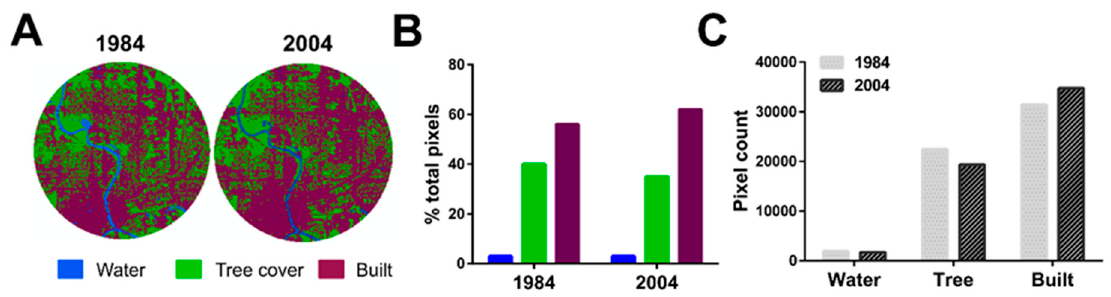
Figure 6. Changes in land use and land-cover near the Des Moines site from 1984–2004. A supervised classification of land use/land cover was performed for 1984 and 2004 to measure built-up land (maroon) and tree-covered land (green) over time using a 4km fixed area around the Des Moines trap site ( A ). Changes in land use/land cover classification are displayed by each year according to classification ( B ) or by classification over time ( C ). Values are displayed as percentages of total pixels or total pixel count respectively. Land use classifications falling under the agriculture or bare terms were not identified for the Des Moines site and were therefore excluded in the presentation of the data.